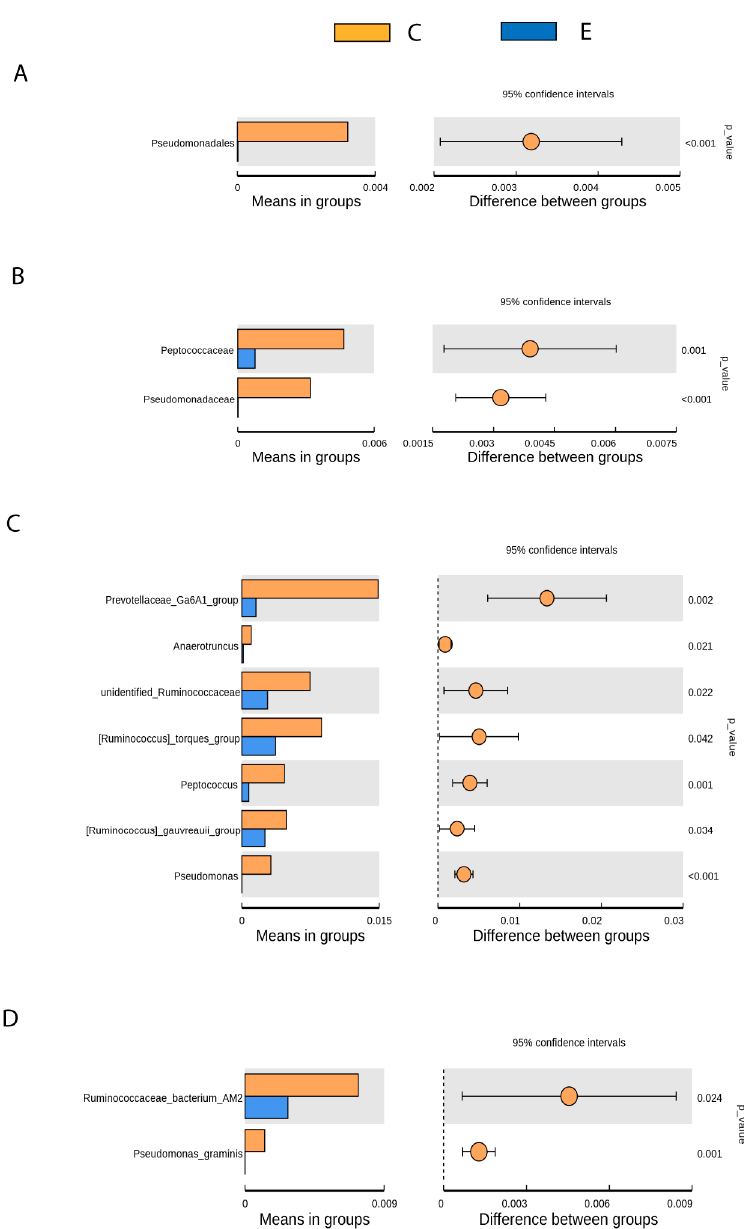
Figure 4. T-test results corresponding to significant differences in the distribution of the relative abundance of bacteria between controls (C) and drug-naive epileptic dogs (E) at different levels: order ( A ), family ( B ), Genus ( C ) and Species ( D ).